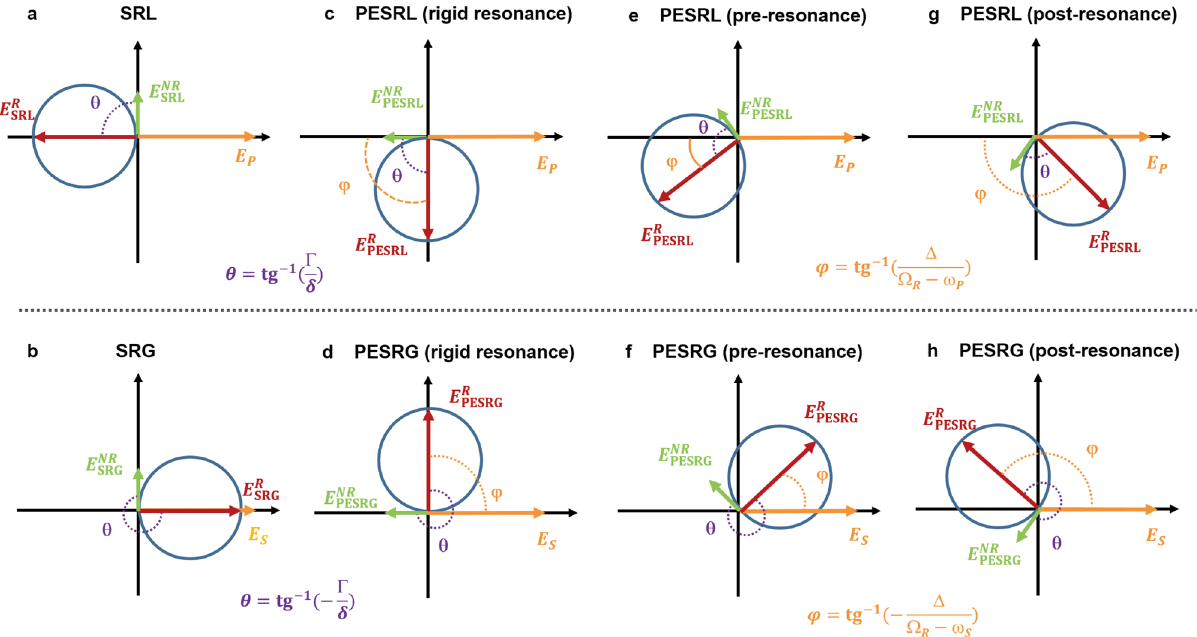
Figure 1: Phasor graphs of stimulated Raman scattering (SRS) and plasmon-enhanced stimulated Raman scattering (PESRS). Phasor rep- resentation of stimulated Raman loss (SRL) (a) and stimulated Raman gain (SRG) (b) without plasmon field, plasmon-enhanced stimulated Raman loss (PESRL) (c) and plasmon-enhanced stimulated Raman gain (PESRG) (d) at rigid plasmon resonance, PESRL (e) and PESRG (f) at plasmon pre-resonance, and PESRL (g) and PESRG (h) at plasmon post-resonance. E P and E S are set as a reference fi eld with zero